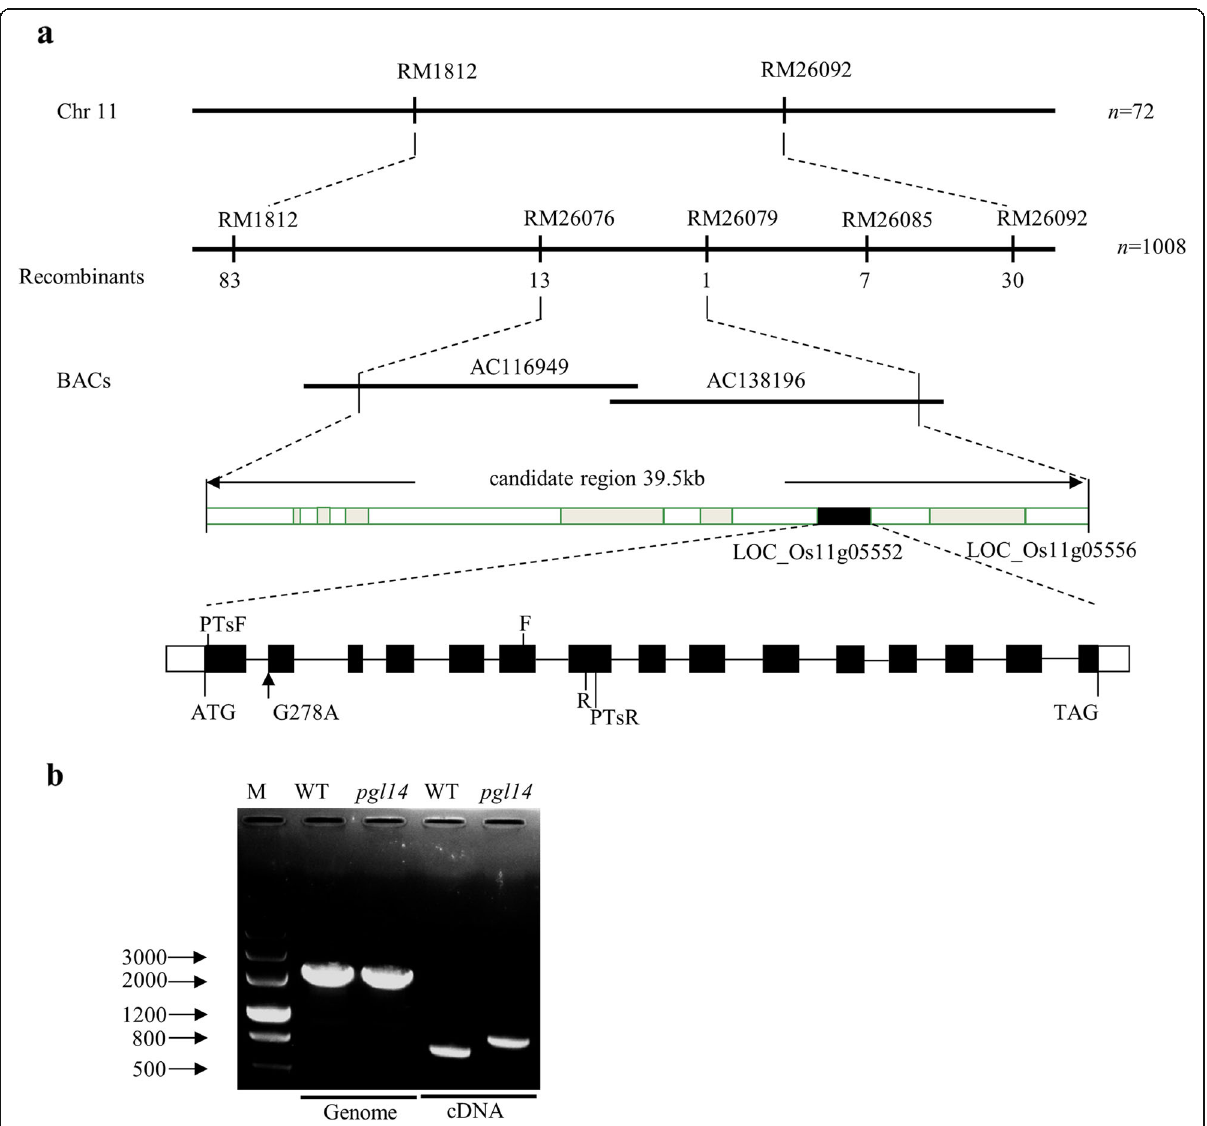
Fig. 1 Map-based cloning of PGL14. a PGL14 localizes to the short arm on chromosome 11 between RM26076 and RM26079, and is narrowed down to a 39.5 kb region covering the bacterial artificial chromosome clones AC116949 and AC138196. The 39.5 kb region contains 7 putative ORFs, the black box indicates LOC_Os11g05552 , gray boxes indicate the other ORFs. LOC_Os11g05552 consists of 15 exons and 14 introns indicated as blank boxes and lines, respectively. The black arrow indicates the point mutation (G278A) at 1st intron splicing site. PTsF and PTsR are the forward and reverse primers for PCR analysis in ( b ). F and R are forward and reverse primers for qRT-PCR analysis; b RT-PCR shows different transcripts from WT and pgl14 . The genomic DNA was used as a